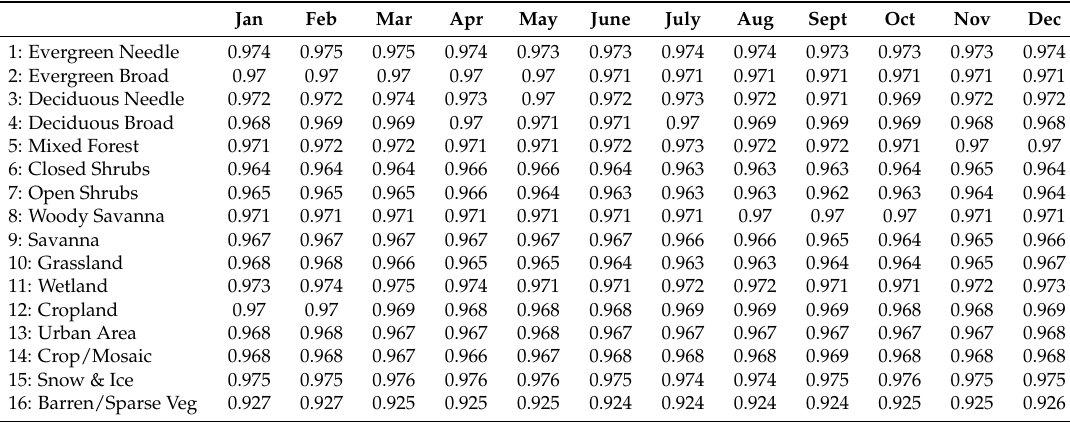
Table 3. Average CAMEL 2000–2016 monthly climatology BBE for the 8–13.5 µ m region for IGBP land cover categories.